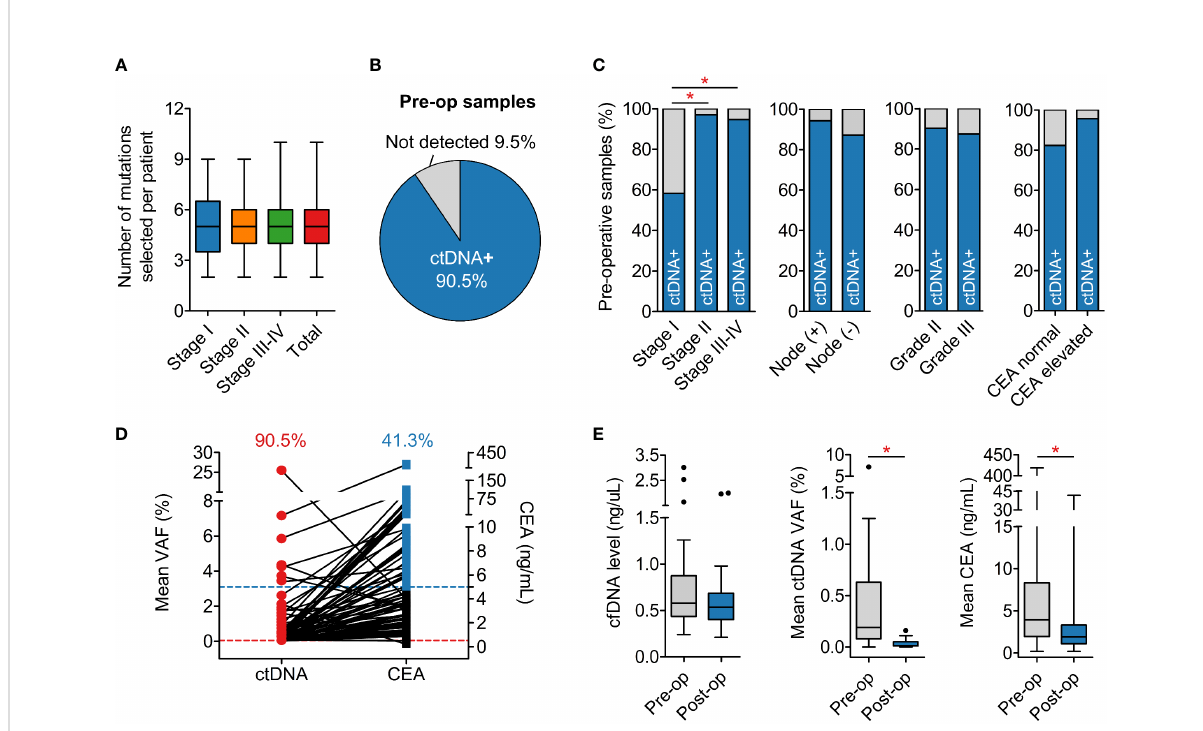
FIGURE 4 Detection of ctDNA in plasma samples. (A) The average number of mutations selected to track was 5 mutations per patient regardless of cancer stage. (B) Detection rate of ctDNA in pre-operative plasma samples was 90.5%. (C) Pre-operative ctDNA detection rate was associated with TNM stage, as the rate in stage I was signi fi cantly lower than in stage II and III. Nodal involvement, histological grade and CEA level status did not affect the detection rate. (D) Pre-operative CEA level was found elevated ( ≥ 5 ng/mL) in only 41.3% patients. (E) Total levels of cfDNA were not different between pre-operative and post-operative plasma samples while ctDNA and CEA levels signi fi cantly reduced after surgery. *P < 0.05; Kruskal-Wallis and post hoc Dunn ’ s test for (A) ; Chi-squared test and Fisher ’ s exact test for (C) ; Mann-Whitney U test for (E)